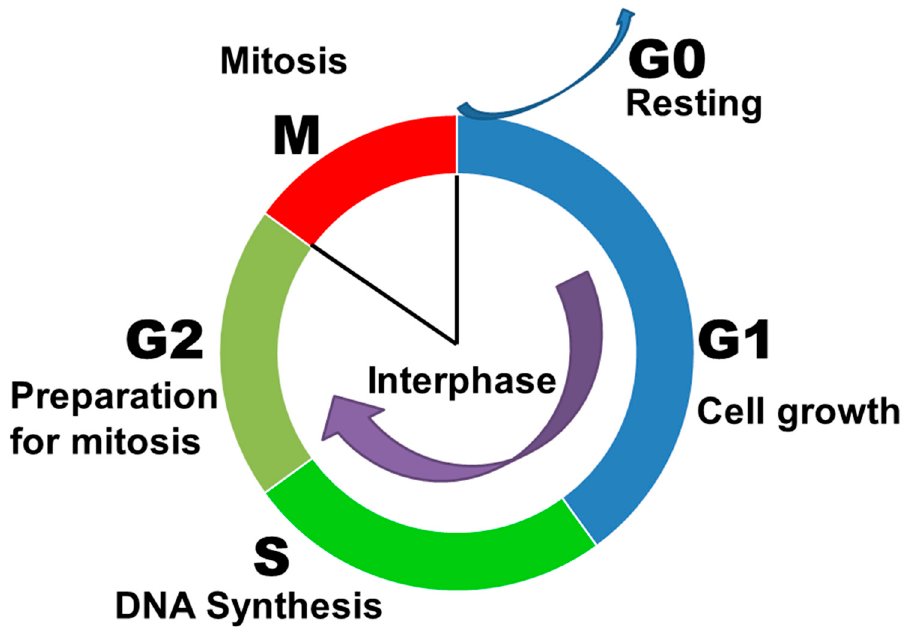
Figure 1. Cell cycle of eukaryotic